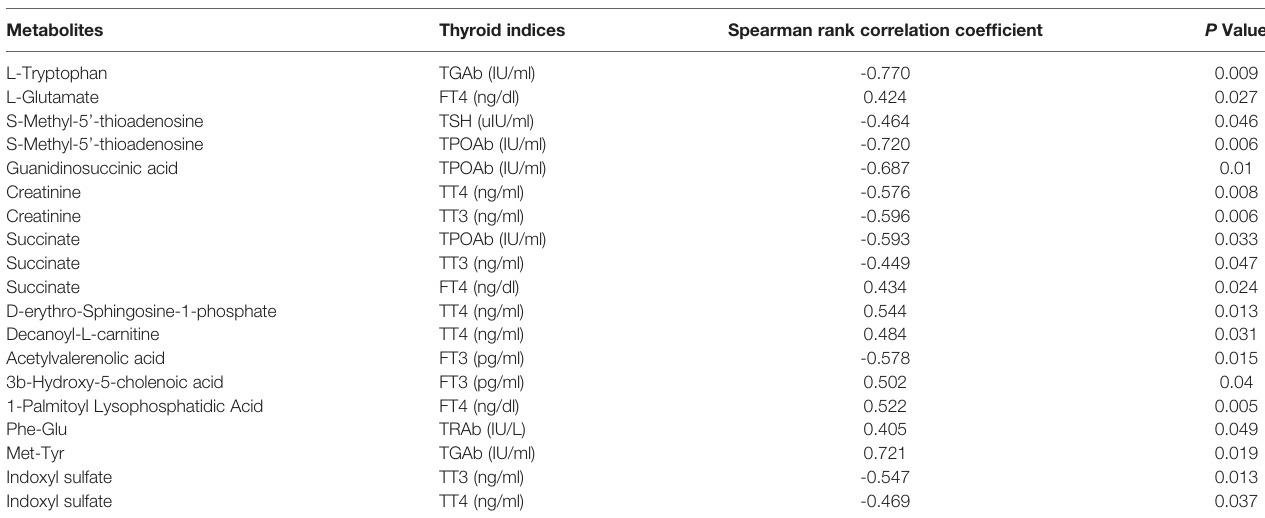
TABLE 4 | Relationship between thyroid indices and metabolites levels in GD children.